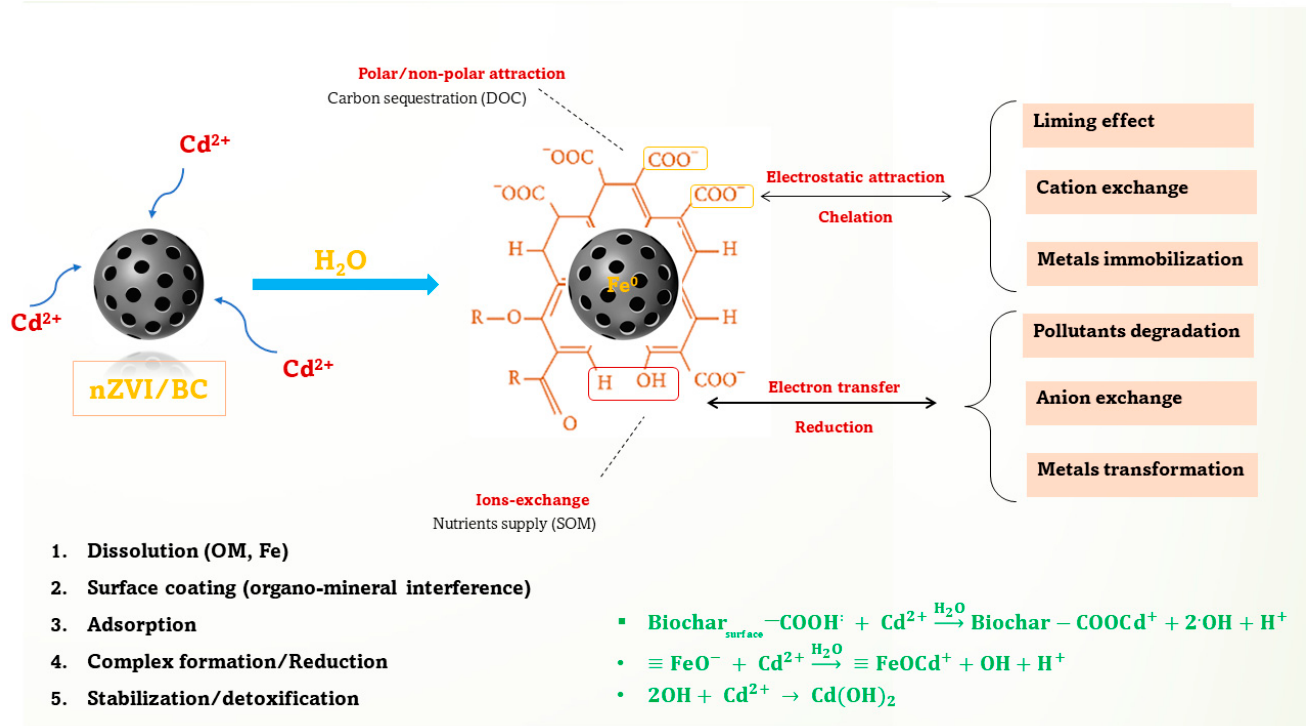
Figure 8. Possible Cd removal mechanisms on nZVI/BC.